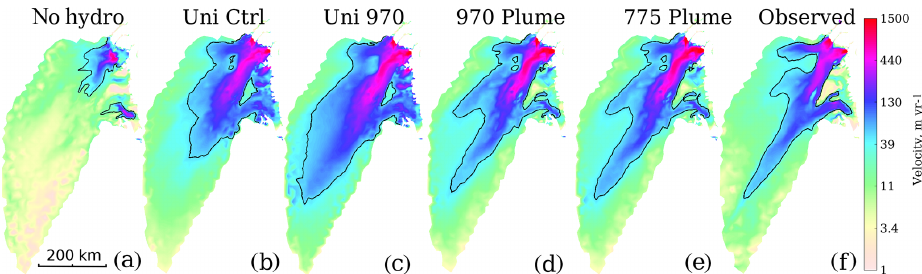
Figure 5. Surface velocity results from the noHydro simulation (a) with effective pressure approximated to the hydrostatic pressure assuming direct connection to the ocean, commonly used in ISSM. Uni control (b) and plume970-uni experiments (c) use a uniform friction coefficient α set equal to 90(ms − 1 ) 1 / 2 . Corresponding GHF, basal melt rates and effective pressure are the same as the control simulation and plume970, shown in Fig. 2. For reference we include (d) and (e) , respectively, showing the plume970 and plume775 simulations (same as Figs. 2q, and 4o), and (f) showing the observed surface velocities interpolated onto the model mesh. Black lines show the 50myr − 1 velocity